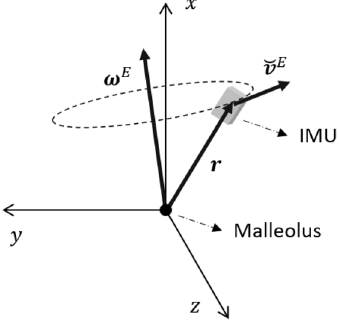
E were computed from the E can be recovered as the tangential velocity associated